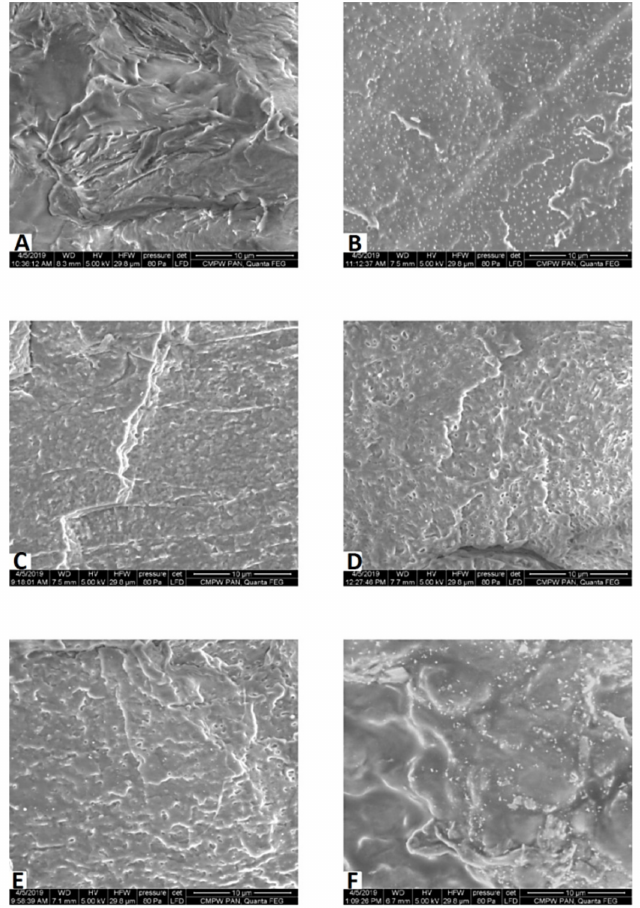
Figure 3. SEM micrographs of the blends: ( A ) poly l-lactide- co -glycolide (PLLAGL) / BS 80 / 20 ( B ) PLLAGL / BS 70 / 30 ( C ) PLLAGL / BSCA 80 / 20 ( D ) PLLAGL / BSCA 70 / 30 ( E ) PLLAGL / CA 80 / 20 ( F ) PLLAGL / CA 70 /